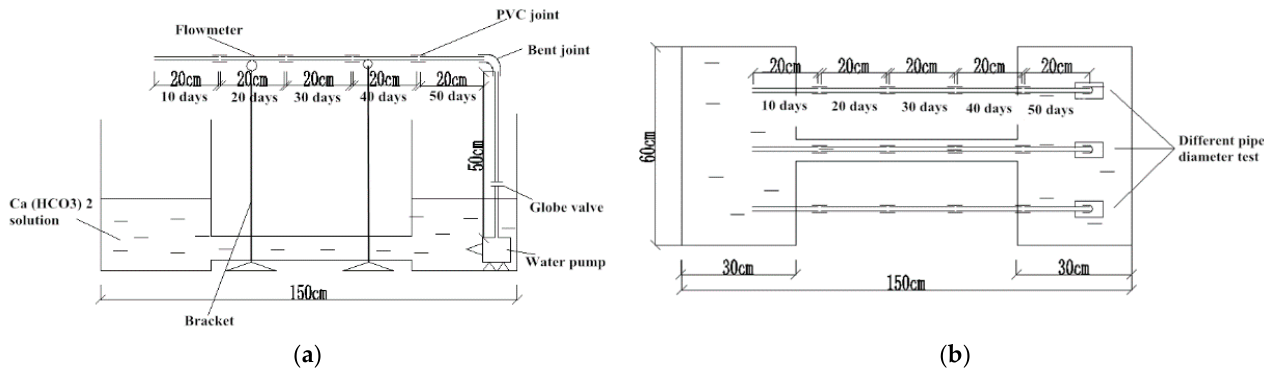
Figure 3. Test device diagram. ( a ) Elevation. ( b ) Top view. Table 1. Influencing factors of the tests.